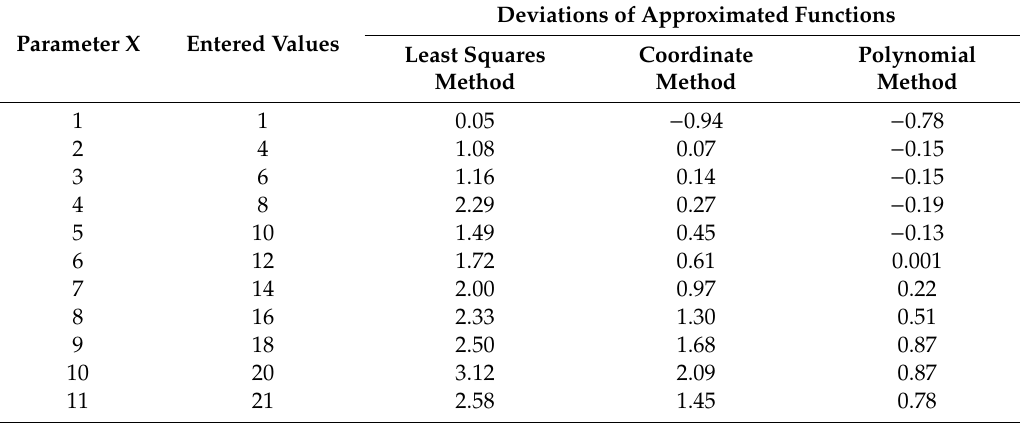
Table 2. Evaluation of machine weight approximation.